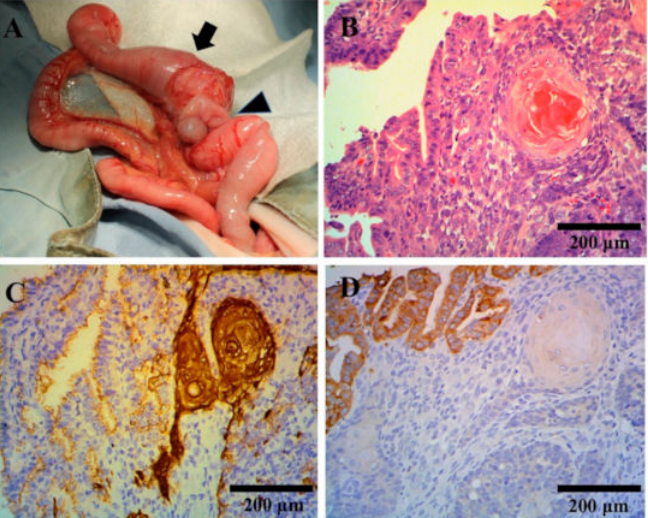
Figure 1. Macroscopic and histopathological tumor findings. ( A ) Macroscopic tumor findings. The mass originatedfromtheileum(arrow)proximaltotheileocecal(arrowhead)region. ( B – D